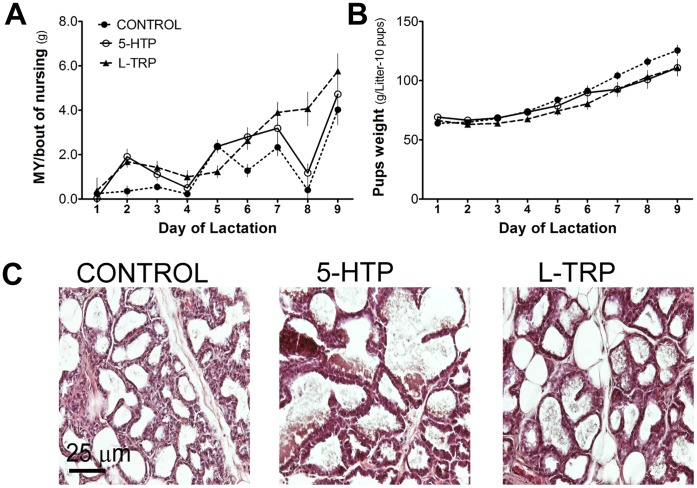
Feeding diets enriched in 5-HTP and L-TRP does not affect milk yield, pup growth or mammary gland structure.(A) Milk yield (MY) estimated by weigh-suckle-weigh method. (B) Daily litter weights (g, d1 to d9 of lactation). (C) Hematoxylin and eosin stained sections of mammary glands collected on d9 of lactation (20X magnification), in Sprague-Dawley rats fed CON, 5-HTP, and L-TRP.